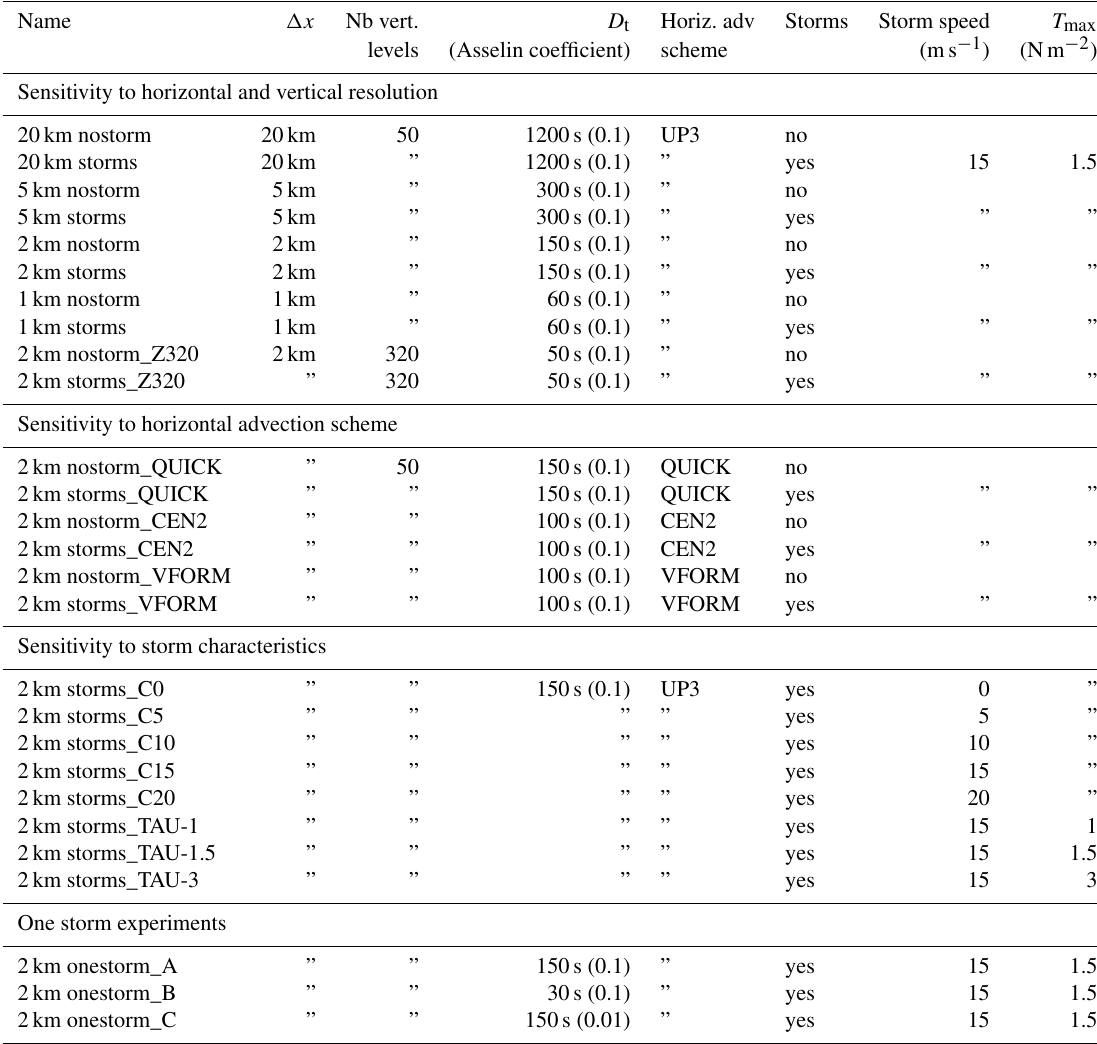
Table 1. Summary of numerical